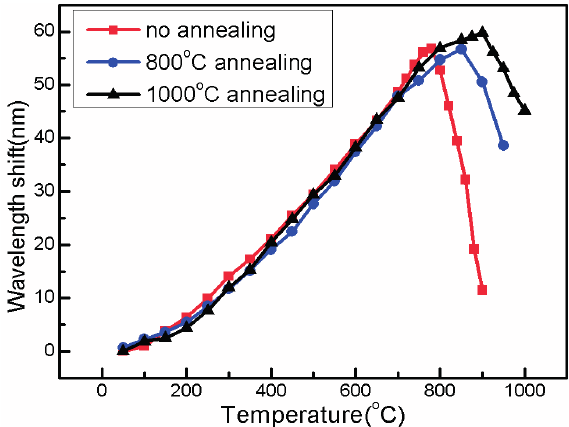
Figure 7. Measured interference dip wavelength versus temperature under different annealing conditions: no annealing ( Red line , blue-shift point at 780 °C), 800 °C annealing ( Blue line ,